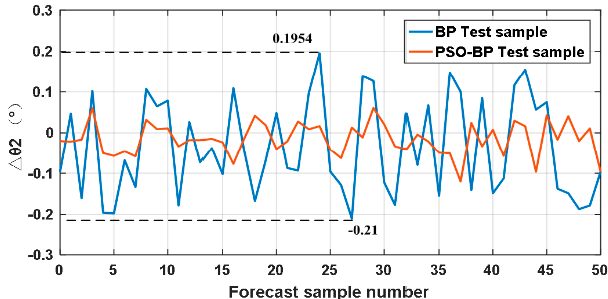
Figure 8. Error contrast of test set’s θ 2 .